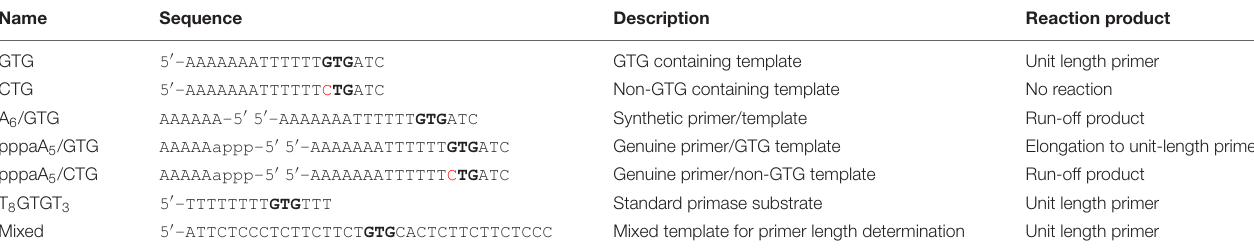
TABLE 1 | DNA substrates used in this